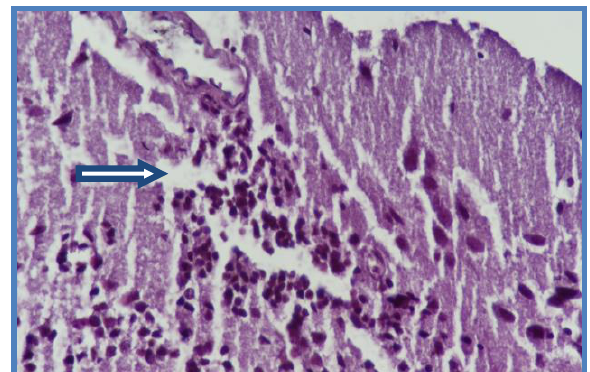
Figure, 1: Odema, Congestion of Neural Cells and Aggregation of Glial Cells in the Infected Brain, Tissue of Mice within 5 Days P. I. Stained with (H and E) (100X).